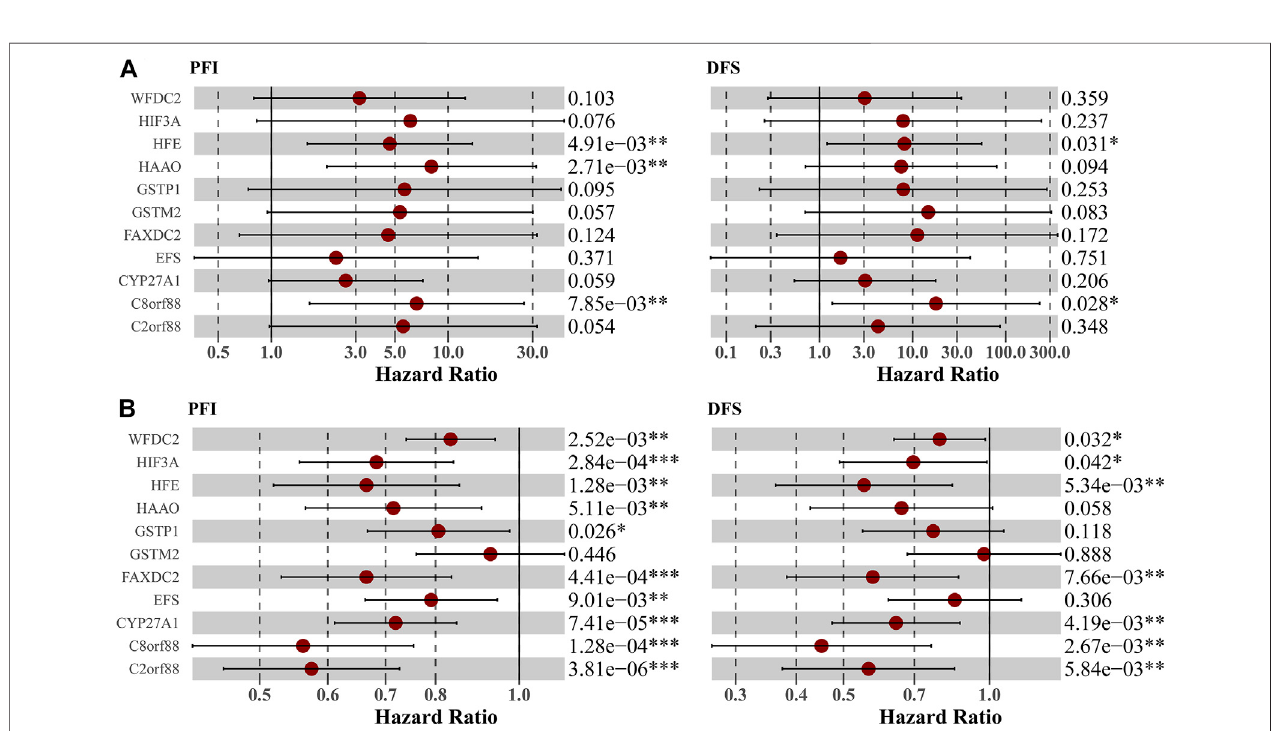
FIGURE7| Validationofprognosticimplicationsofdrivergenesin (A) methylationpro fi leand (B) expressionpro fi le.UnivariableCoxanalysiswasconducted.Label (*) means p < 0.05, label (**) means p < 0.01, and label (***) means p < 0.001.